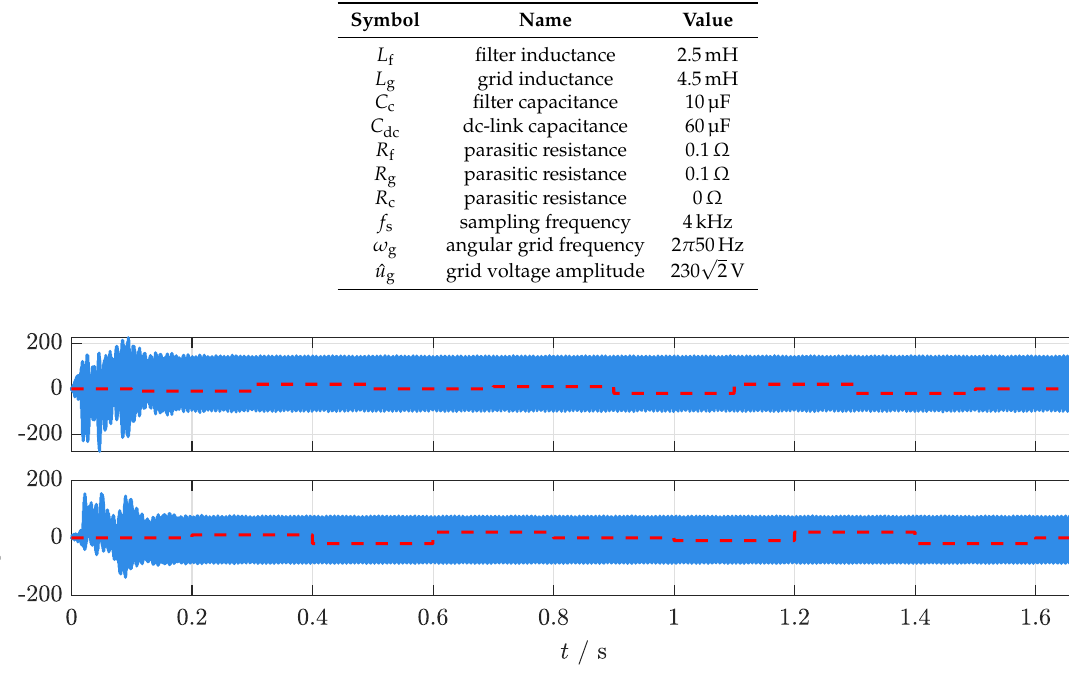
Figure 3. Simulation results of a continuous-time LQR current controller design with integral feedback, which lead to instability (bang-bang-like behavior). [Color code: simulated currents i d filter voltages u d c , and u q c , reference currents i d